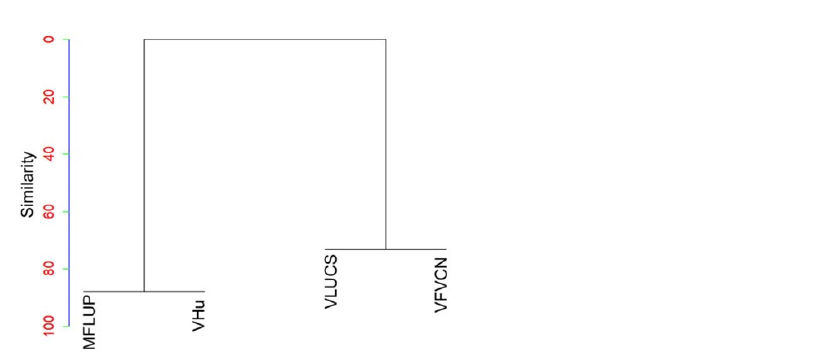
Figure 7. Dendrogram of similarity of the methods used in this study to assess the physical vulnerability of structures.